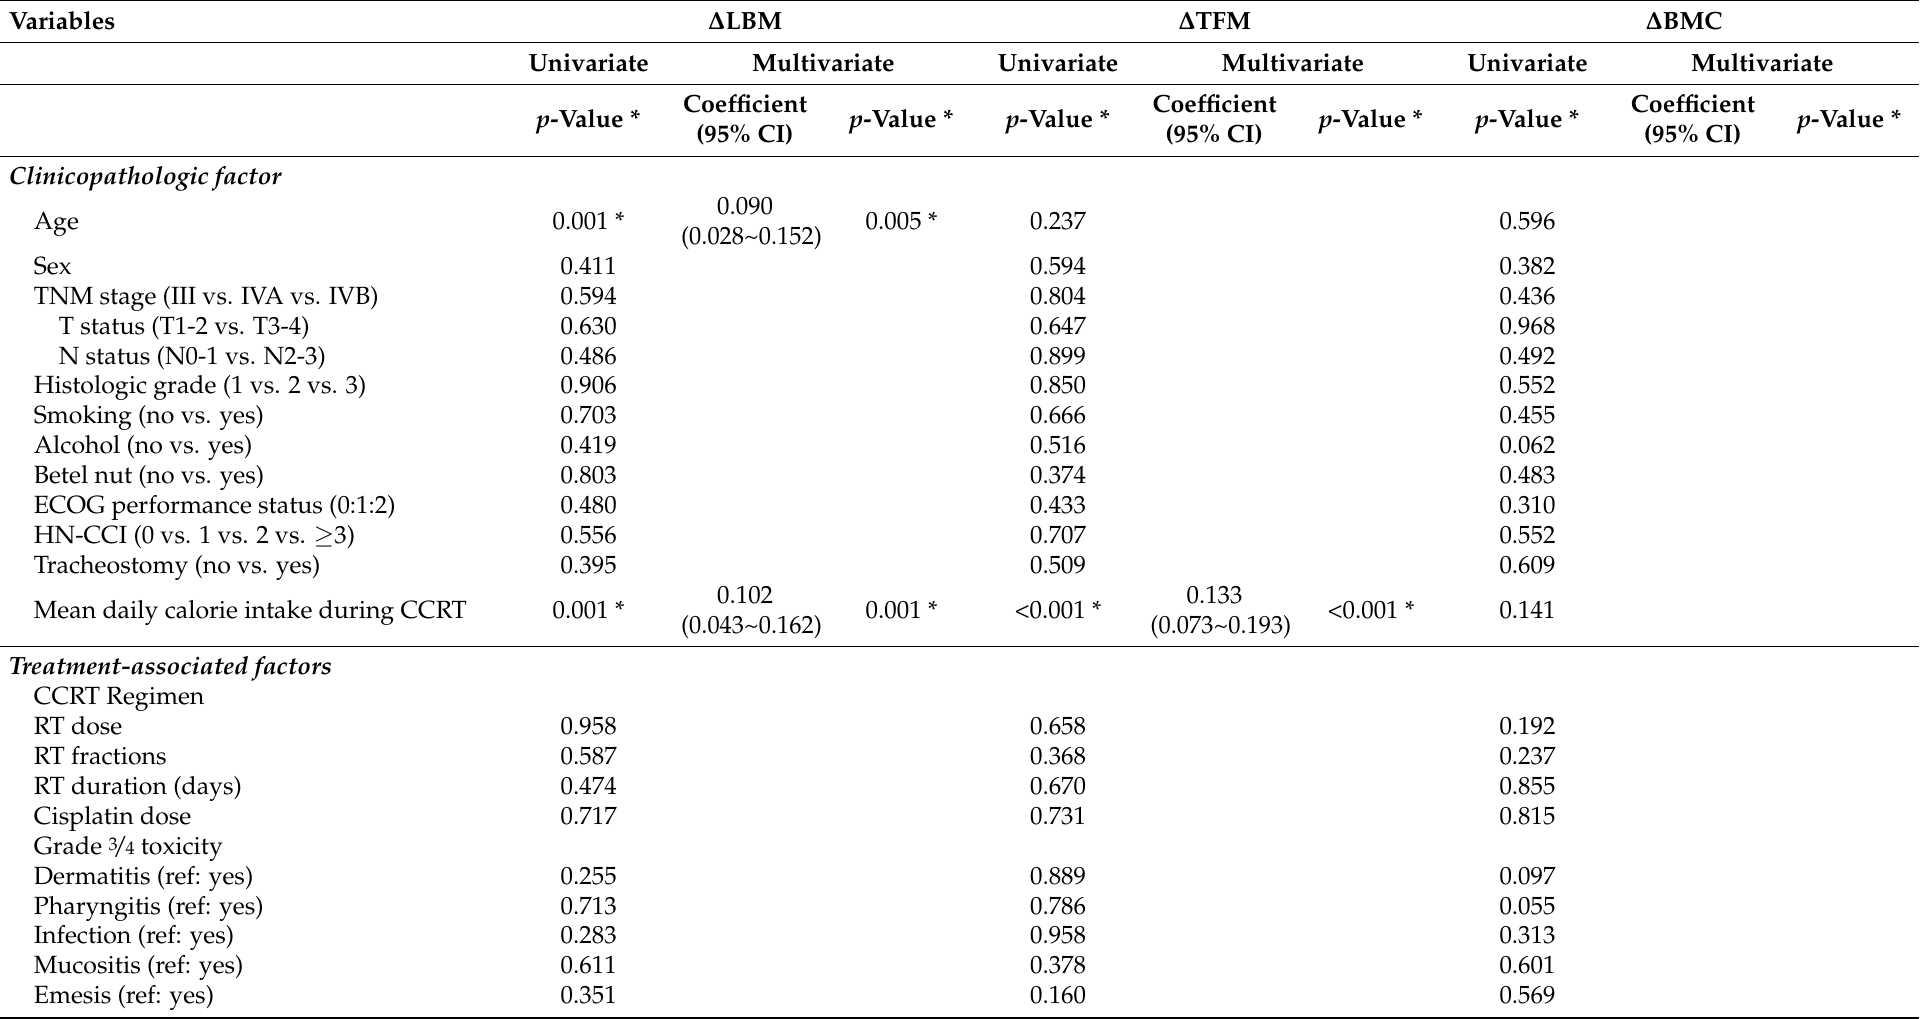
Table 3. Univariate and multivariate associations of clinicopathologic variables, treatment-related factors, nutritional and inflammatory markers with changes of body composition parameters over the CCRT course in 69 patients with oral cavity cancer undergoing adjuvant